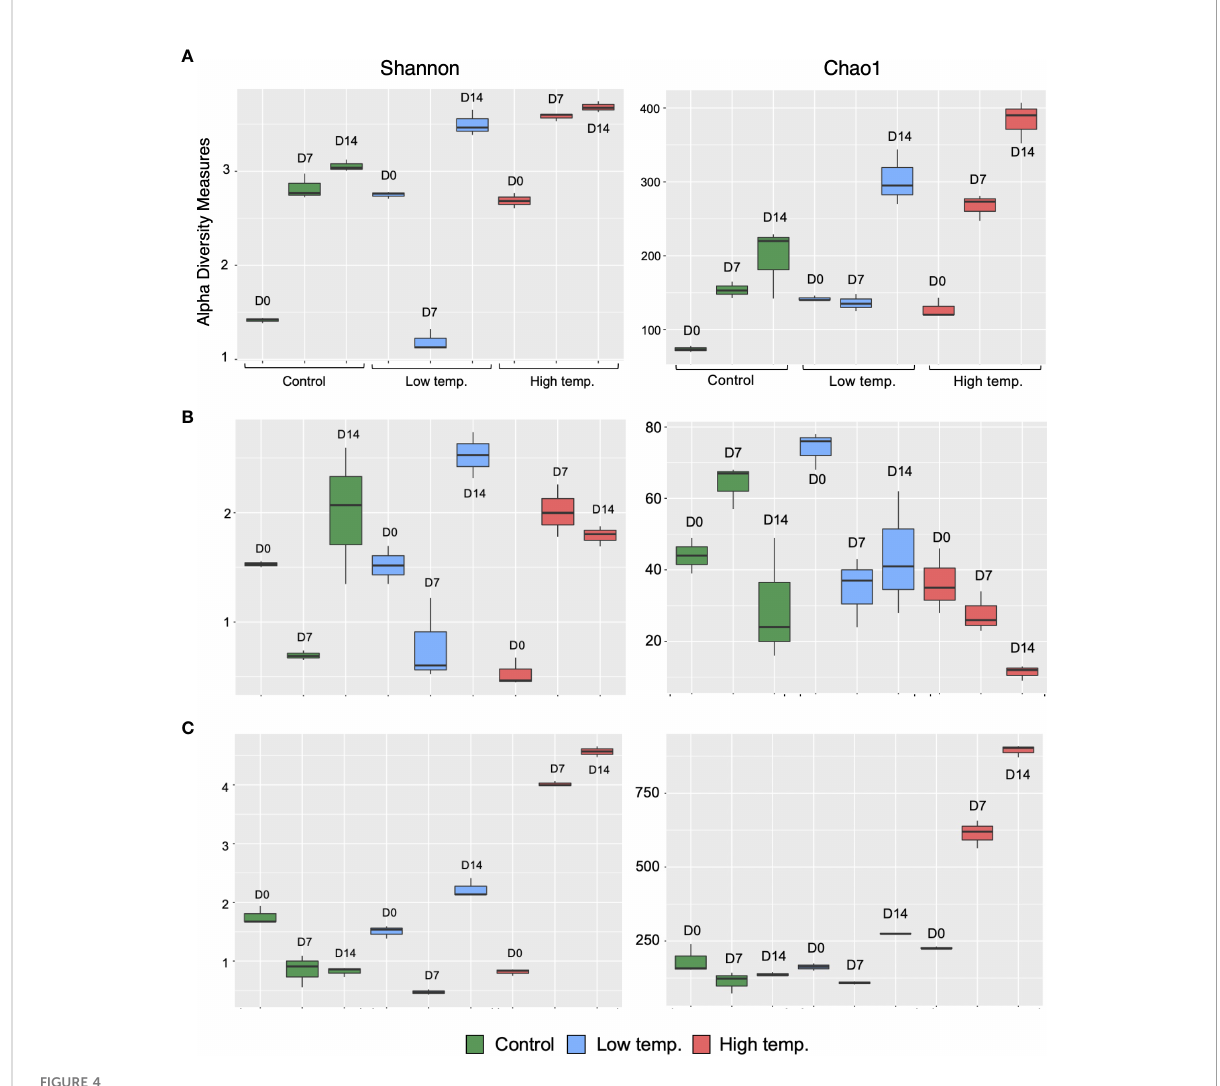
FIGURE 4 Alpha diversity of the microbial communities in the feces (A) , skin mucus (B) , and surrounding water (C) of chum salmon at each sampling point. Alpha diversity is indicated by the Shannon (left column) and Chao (right column) indices at control (green), low (blue), and high (red)